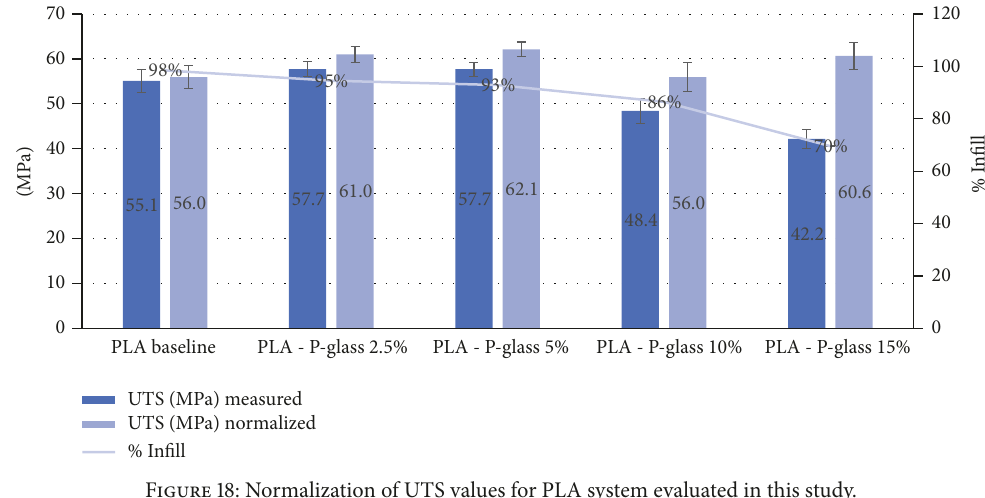
Figure 18: Normalization of UTS values for PLA system evaluated in this